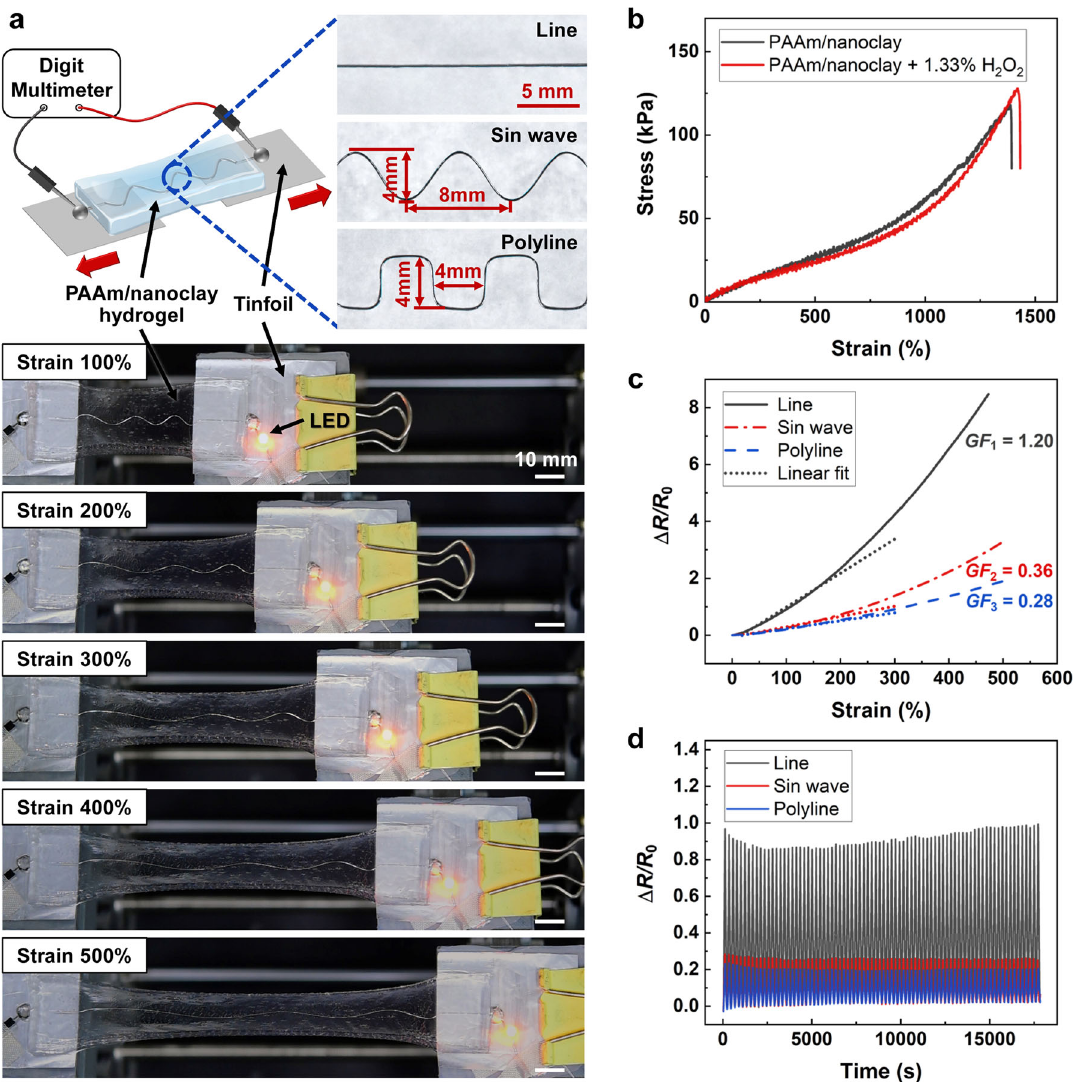
Fig. 4 Characterization of tensile electrical properties of liquid metal-hydrogel electronics. a Schematic of tensile test and photos of three con fi gurations of liquid metal circuits in the PAAm/nanoclay hydrogel, and snapshots of the hybrid hydrogel with printed sin-wave liquid metal at different tensile strains. The liquid metal-hydrogel electronics was connected to a yellow LED to show the working state. b Tensile stress-strain curves of PAAm/nanoclay hydrogel, without and with 1.33% H 2 O 2 . c Relative resistance change as a function of tensile strain for liquid metal-hydrogel electronic devices with three con fi gurations. d The relationship between relative resistance change and time for liquid metal-hydrogel electronic devices with three con fi gurations during the fi rst 80 cycles of